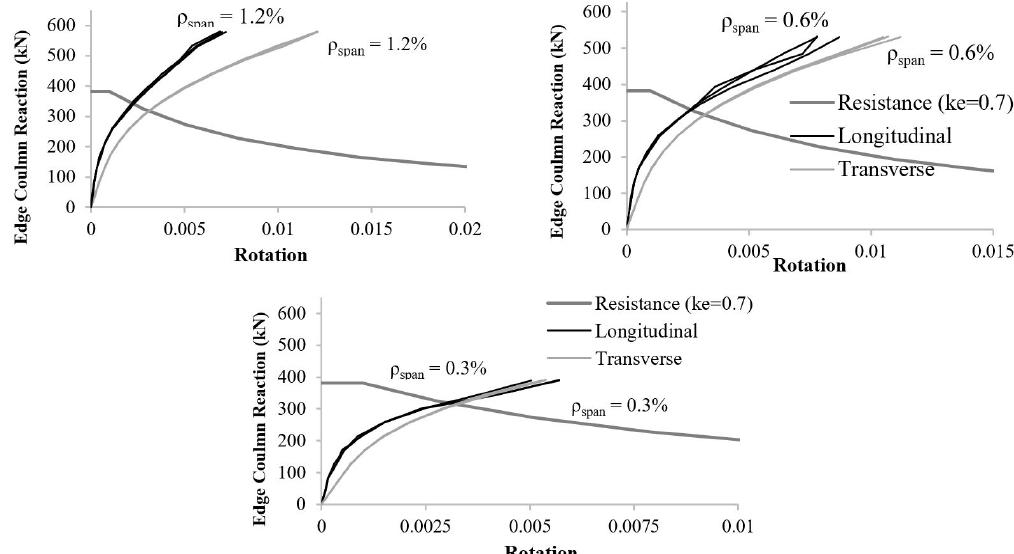
Figure 14. Comparison between longitudinal and transverse rotations for the edge column of the subassembly parametric